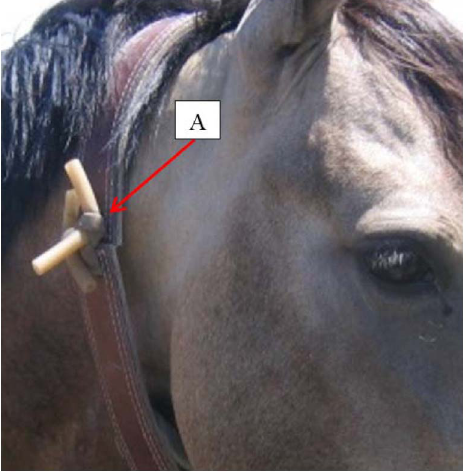
Figure 2. An adult domestic horse fitted with a commercially available VHF/GPS collar. A: location of remote-detonated detach- ment device immediately behind the jowl and jugular furrow prior to modification.